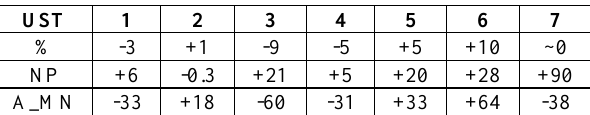
Table 2. Percentage of change of three metrics in each UST between 1985 and 2015. %=percentage of participation in the whole study area; NP=number of patches; A_MN= patch mean